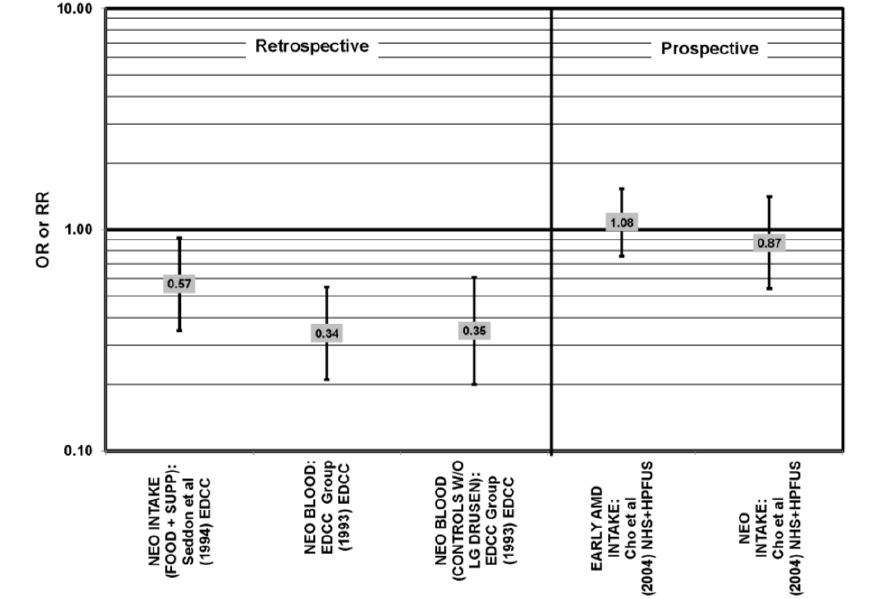
Figure 34. Odds or risk ratio for exudative AMD (EXUD) or neovascular AMD (NEO); high vs. low intake or blood levels of total carotenoids: retrospective and cross-sectional